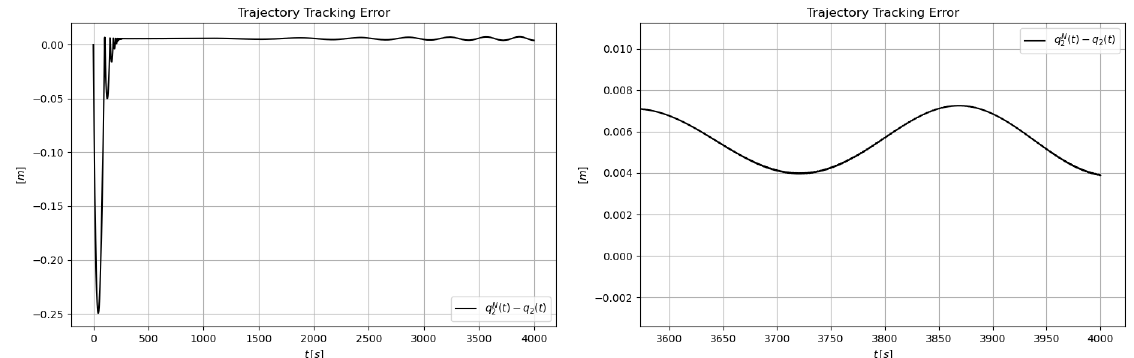
Figure 7. For Λ max = 5.5 and T = 5 ∆ t with adaptivity: Trajectory tracking with its zoomed in excerpt (upper Left & Right Sides) and tracking errors with its zoomed in excerpt (below Left & Right Sides).